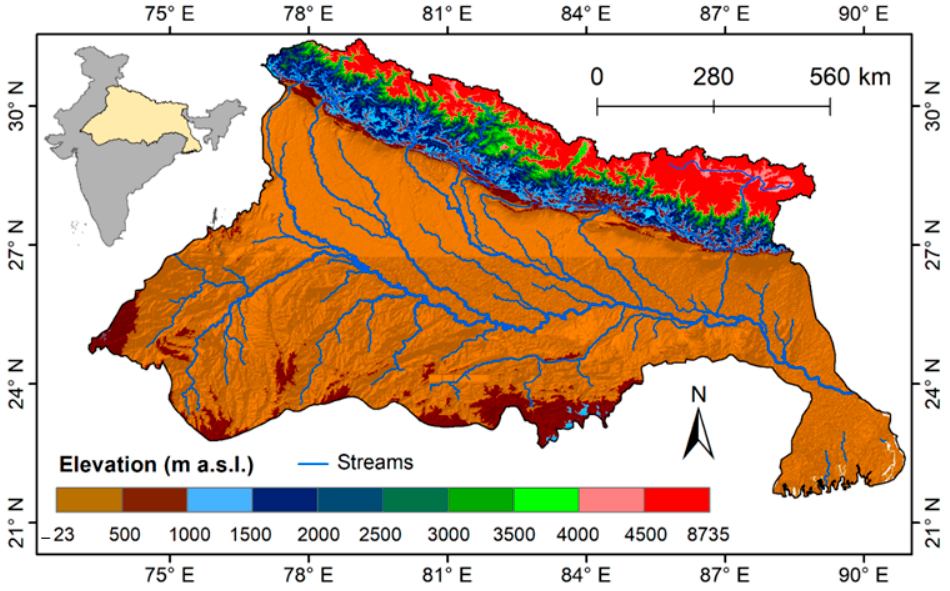
Figure 1. The Ganga river basin’s elevation map and its tributaries along with a scale of the varying elevation. The GRB spreads out into four countries, India (79%), Nepal (14%), Bangladesh (4%), and China (3%). In India, it covers 861,452 km 2 , which is nearly 26% of the country’s total geographic area [50]. The GRB originates in the Himalayan Mountains at the Gangotri glacier’s snout, at an elevation of ~7000 m a.s.l. The Bhagirathi and Alaknanda Rivers’ confluence occurs in Devprayag, which is then officially called the Ganga River. The Ganga River’s main tributaries are the Yamuna, the Ramganga, the Gomti, the Ghaghra,